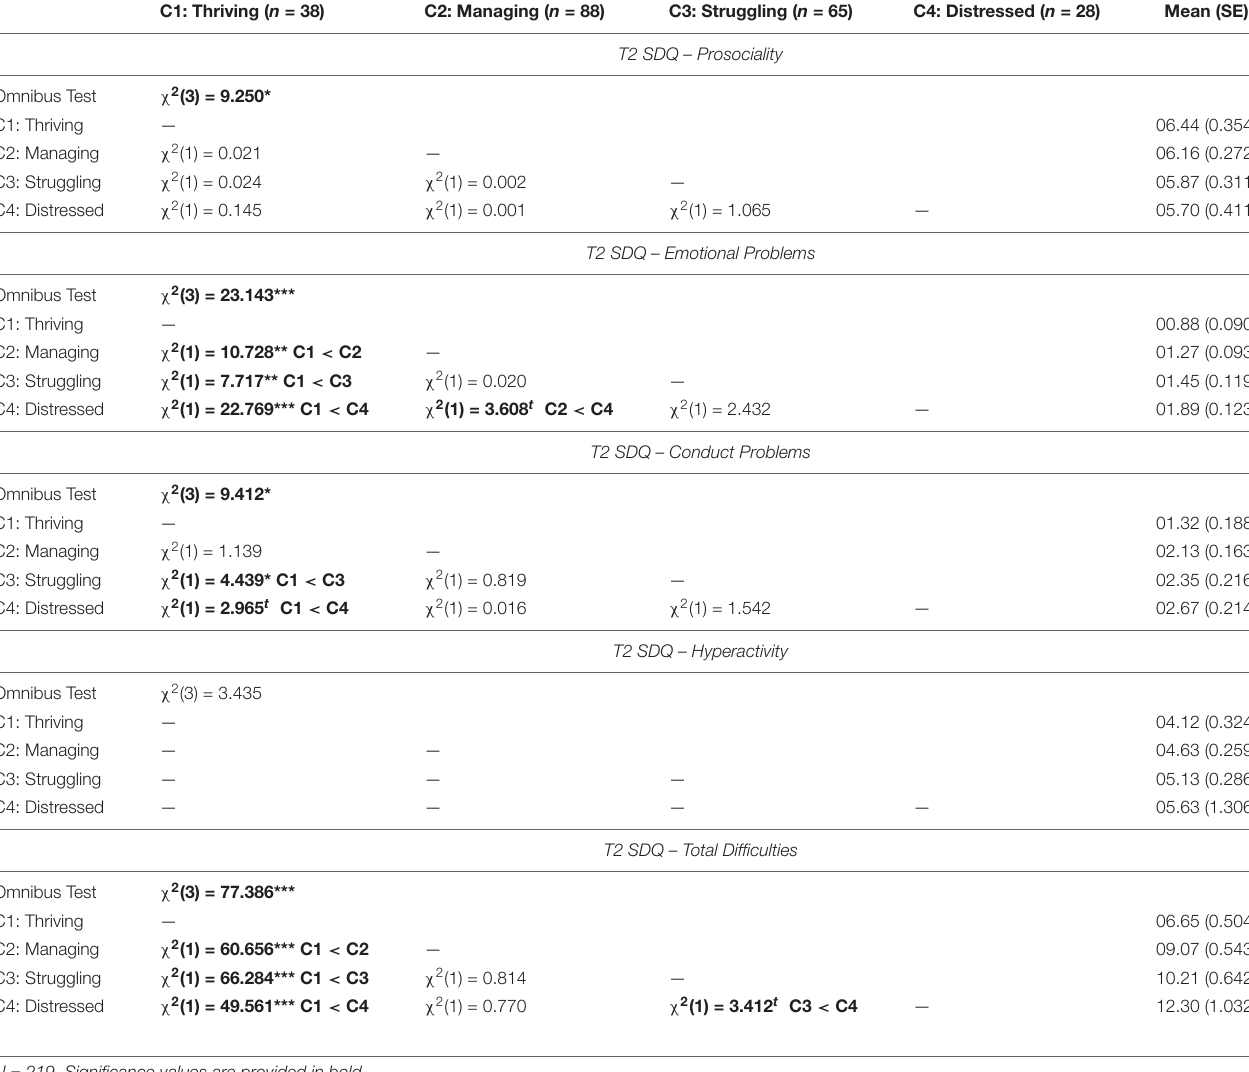
TABLE 4 | Family functioning profiles predicting distal child outcomes at Time 2 (September–October